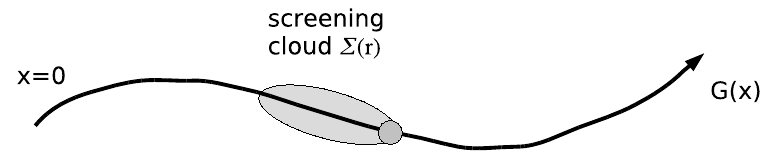
Figure 20. Path-integral interpretation of the screening of a propagating particle. The single-particle lattice Green’s function, G l , describes the quantum phase and amplitude the particle accumulates along its path as it propagates from space-time location 0 to x . It is poorly approximated by the cluster Green’s function from a small cluster calculation, G l G c , especially when x , r L c , the linear ≈ ≤ cluster size. Its self-energy, which describes generally short-ranged r screening processes, is well approximated Σ l Σ c , by a small cluster calculation, especially when the cluster size L c is greater ≈ than the screening length. As discussed in Section 2 this screening length f TF r which may be less ≈ than an Angstrom for a good metal. Therefore, rather than directly approximating the lattice Green’s function by the cluster Green’s function, the cluster self-energy is used to approximate the lattice self-energy in a Dyson equation for the lattice Green’s function G l = G l + G l 0 + G l 0 Σ l G l , where G l 0 is the bare lattice Green’s